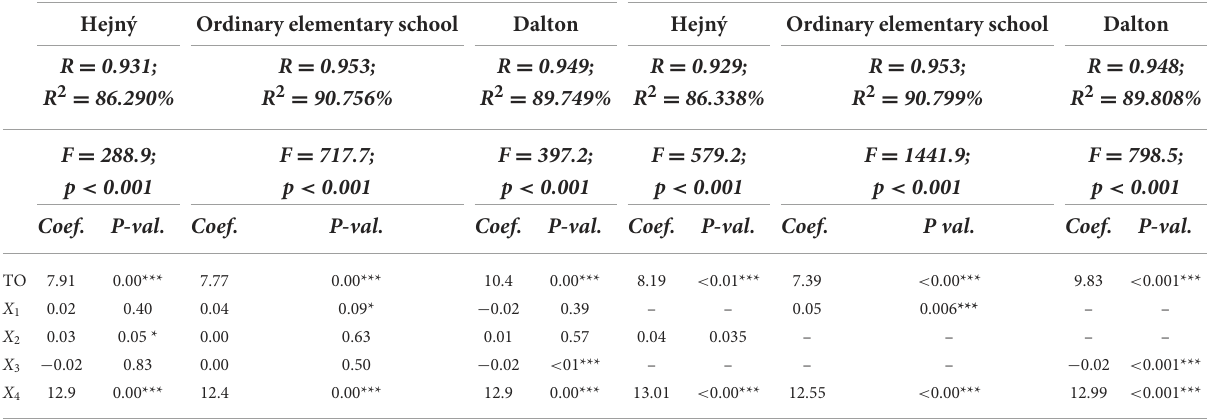
TABLE 2 Chosen parameters of the regression model. Insert all variables at once After removing insignificant variables Hejný Ordinary elementary school Dalton Hejný Ordinary elementary school